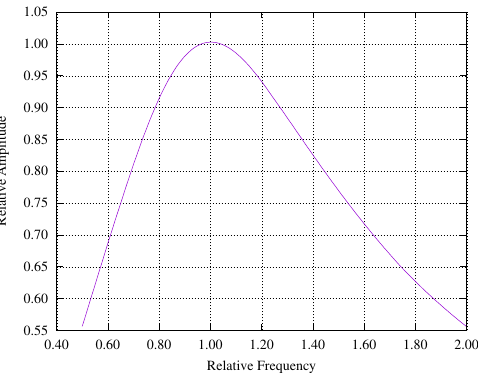
Figure 2. Rate of amplitude max ( x ext ) / max ( x ) attenuation by relative frequency f ext / f o .